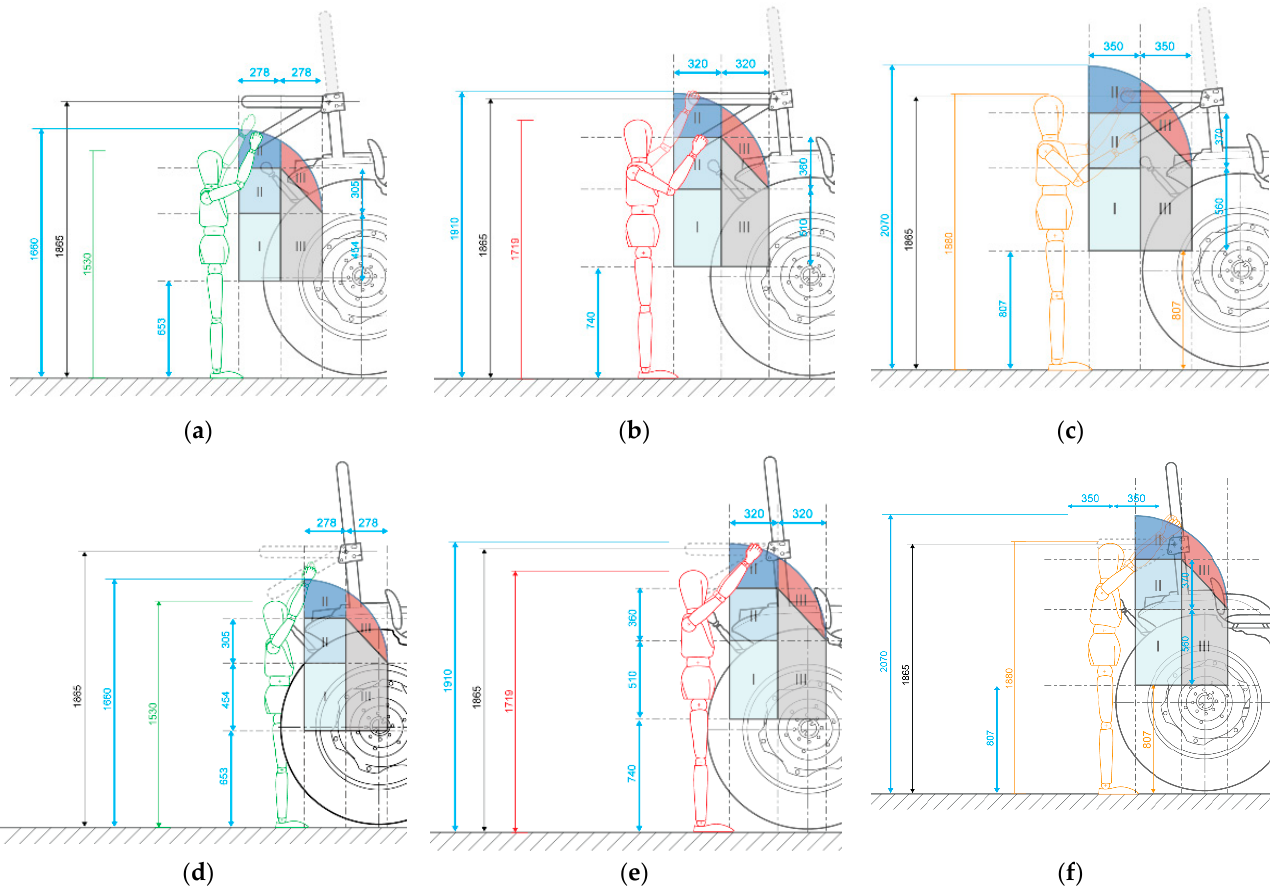
Figure 6. Measurements of the accessible zone redesigned based on the three percentiles figures: ( a ) 5th percentile, ( b ) 50th percentile, ( c ) 95th percentile when the FROPS is at 45° and 90°, and ( d ) 5th percentile, ( e ) 50th percentile, ( f ) 95th percentile when the FROPS is in the upright position.